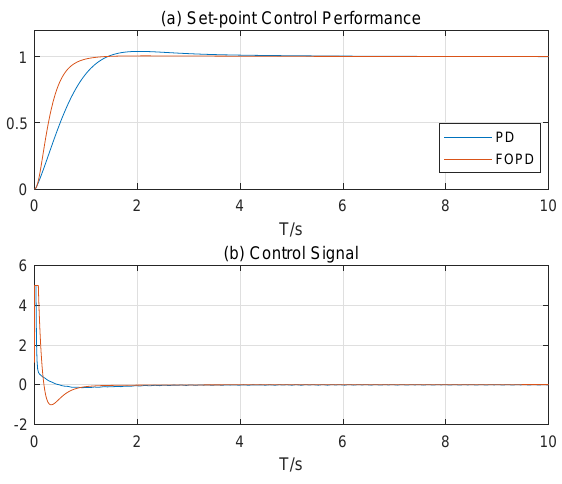
Figure 2. Set-point control performance